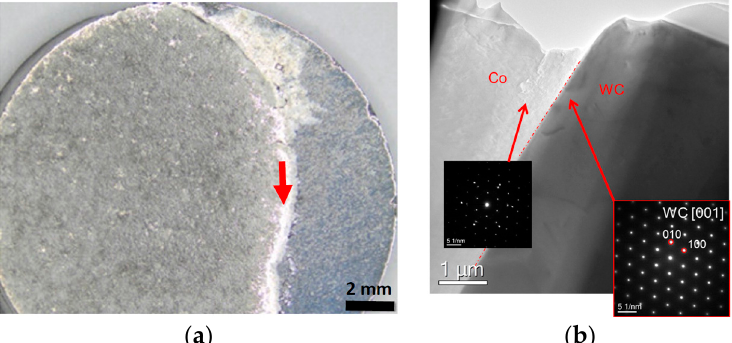
Figure 3. WC-Co interfaces in the sample obtained after melting the alloy with the medium-low carbon content on the WC surface: ( a ) The sample appearance with an arrow indicating where a focused ion beam (FIB) lamella was cut off from the interface region (note that the sample is characterized by complete wetting); ( b ) Interface nano-structure with insets indicating selected area electron diffraction (SAED) patterns.